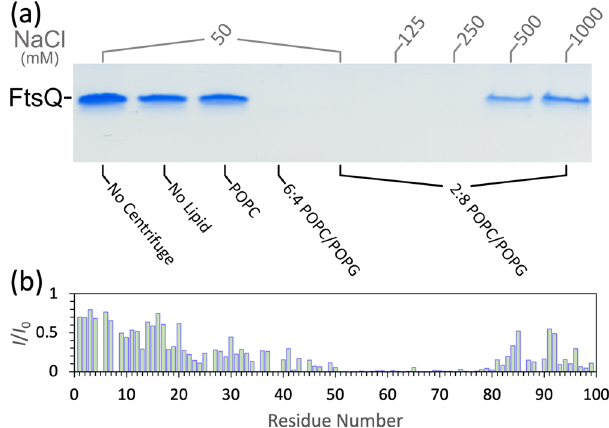
Fig. 4 Characterization of the binding of FtsQ1-99 with membranes. a SDS-PAGE gel indicating the fraction of FtsQ1-99 remaining free of lipid vesicles. Gel samples were of supernatant from the indicated mixtures collected immediately after ultracentrifuge condensation of lipid vesicles. All samples contained 320 μ M FtsQ1-99 in 20 mM Tris (pH 6.85) in the presence of indicated NaCl and/or lipid vesicles with a fi nal protein-to-lipid ratio of 1:20. b Ratio of 1 H- 15 N HSQC peak intensities of 130 µ M uniformly 13 C- 15 N labeled FtsQ1-99 in the presence ( I ) and absence ( I 0 ) of 7:3 POPG/ POPC vesicles (1:10 protein-lipid ratio). Acquired at 800 MHz and 305 K in 20 mM Tris buffer (pH 6.85) with 50 mM